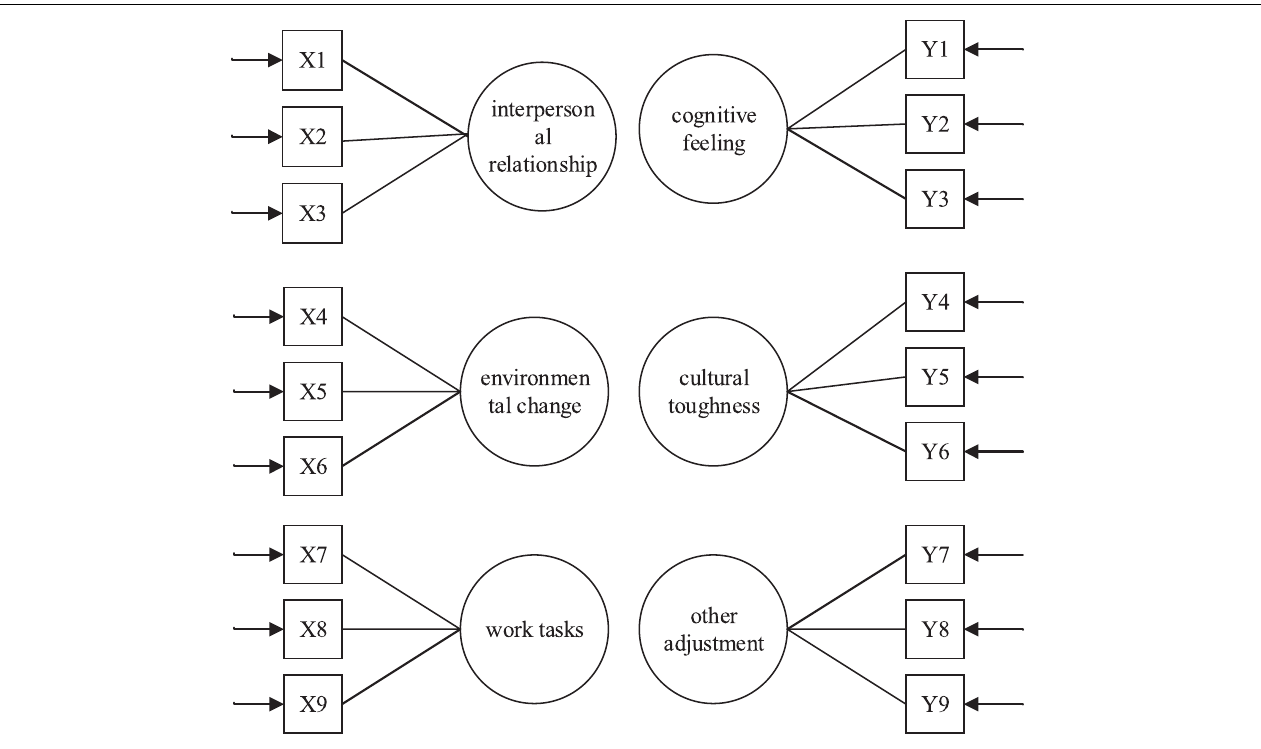
FIGURE 2 | The pressure sources of expatriates based on linear structural relation (LISREL) model.